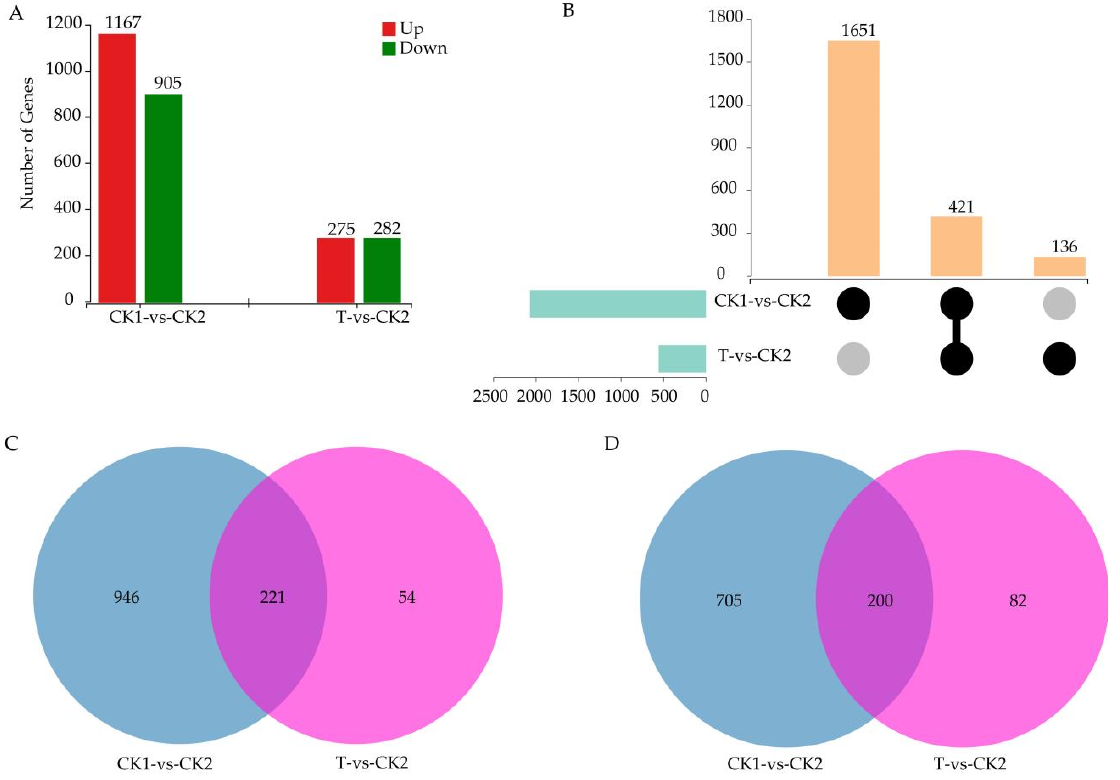
Figure 2. Statistics for DEGs. ( A ) The number of up- and down-regulated DEGs in the root. ( B ) The number of up- and down-regulated DEGs in the leaf. ( C ) Venn diagrams of DEGs for comparison groups in the root. ( D ) Venn diagrams of DEGs for comparison groups in the leaf. CK1 represents watermelon seedlings cultured in normal Hoagland solution; CK2 represents watermelon seedlings cultured in Hoagland solution containing 150 mM NaCl, and T represents watermelon seedlings cultured in Hoagland solution containing 150 mM NaCl and 20 mM